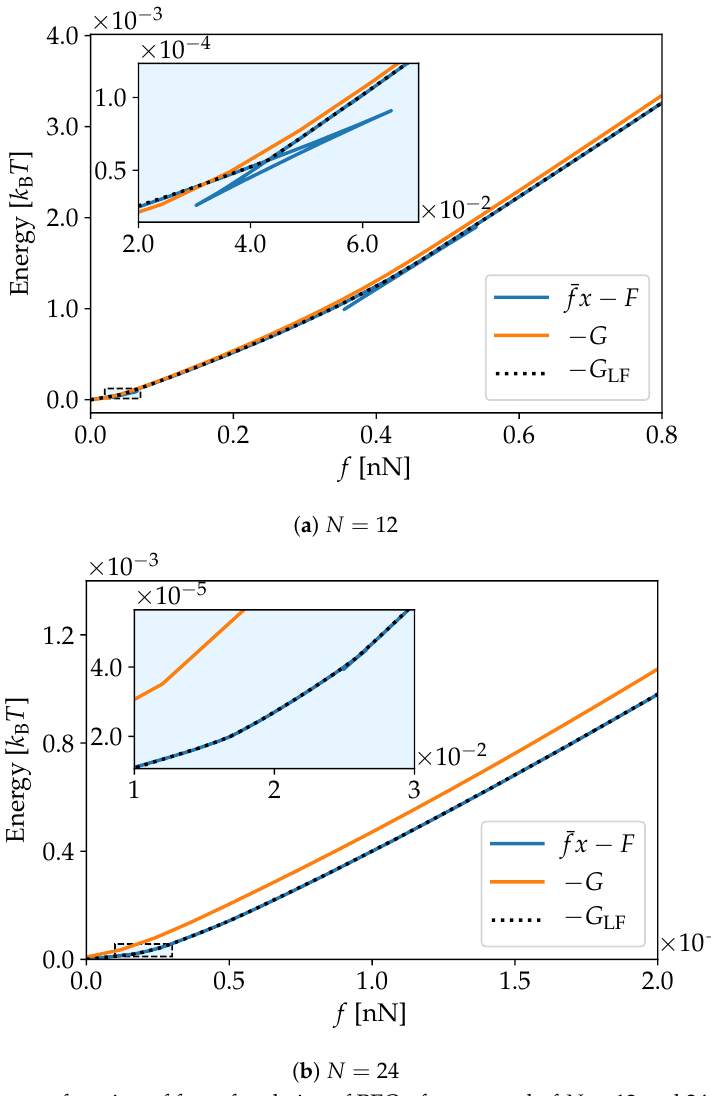
Figure 3. Energy as a function of force for chains of PEO of composed of N = 12 and 24 united atoms. The smallest system displays multiple singularities, one of which is emphasized in the insert. Although less pronounced, singularities can be seen also in the system with N =